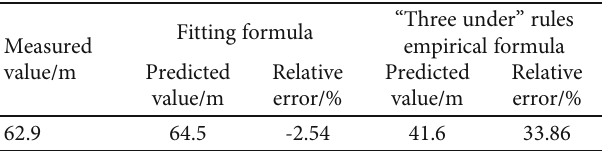
Table 4: Height prediction in a working face of the Shendong mining